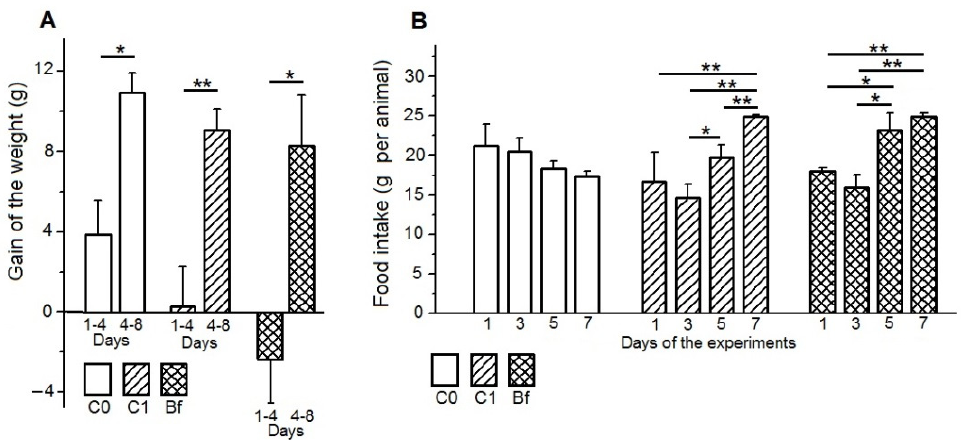
Figure 1. Influence of indigenous bifidobacteria on the gain of weight ( A ) and food intake ( B ) in a rat model of antibiotic-associated dysbiosis. ( A , B ) The rat groups: C0 (control)—without the introduction of antibiotics and autoprobiotics, C1—without the introduction of autoprobiotics after the withdrawal of antibiotics, and Bf—with the introduction of indigenous bifidobacteria after the withdrawal of antibiotics. ( A ) Student’s t -test, * p < 0.01; ** p < 0.003. ( B ) Student’s t -test, * p < 0.05, ** p < 0.003.